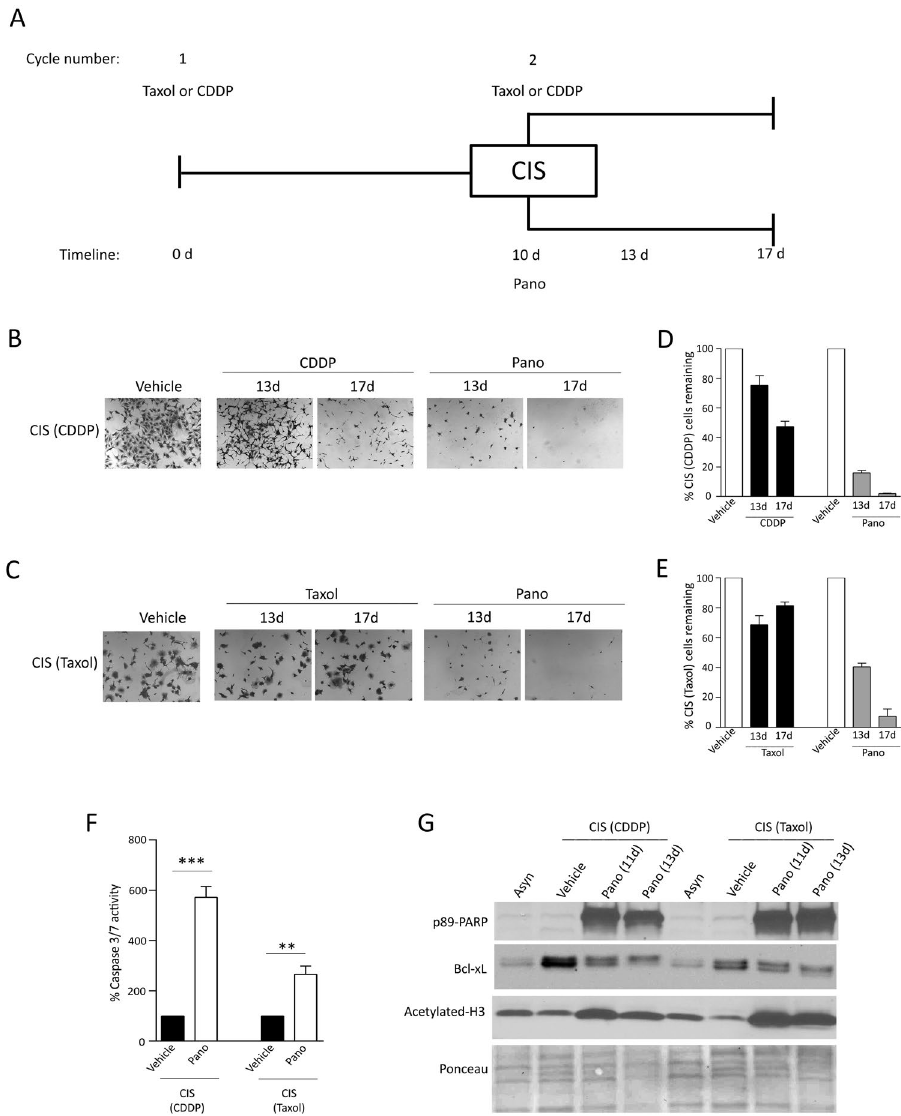
Figure 4. Pano has Senolytic Activity in Chemotherapy-Induced Senescent NSCLC. ( A ) Schema of experimental design. CIS populations of A549 obtained after treatment with either CDDP or Taxol (cycle 1), were subsequently treated with either (i) cycle 2 of chemotherapy (at the same dose as cycle 1), or (ii) pano (200 nM). Cells were assayed for survival at 13 and 17 days post-treatment initiation, corresponding to 3 and 7 days post-cycle 2. Representative SRB-stained images indicate dramatic cell loss following pano-treatment in ( B ) CIS (CDDP - cisplatin), or ( C ) CIS (Taxol) populations (Magnification 5X). Quantitative analysis of cell loss in ( D ) CIS (CDDP) and ( E ) CIS (Taxol) senescent populations following cycle 2 treatment (mean ± SEM, n = 6). Data indicate significant loss ( P < 0.0001: unpaired t -test) for pano-treated cells versus chemotherapy (either CDDP or Taxol) by day 17. Vehicle controls reflect treatment of CIS populations for either duration. ( F ) Increased caspase 3/7 activity in pano-treated (3 days) CIS populations of A549. Bar represents mean ± SEM ( n = 3) and statistical significance (unpaired t -test) is indicated. ( G ) Representative immunoblot showing increased PARP cleavage, decreased Bcl-xL and increased acetylated H3 in both CIS populations of A549 cells following 1- and 3-day treatment with pano (200